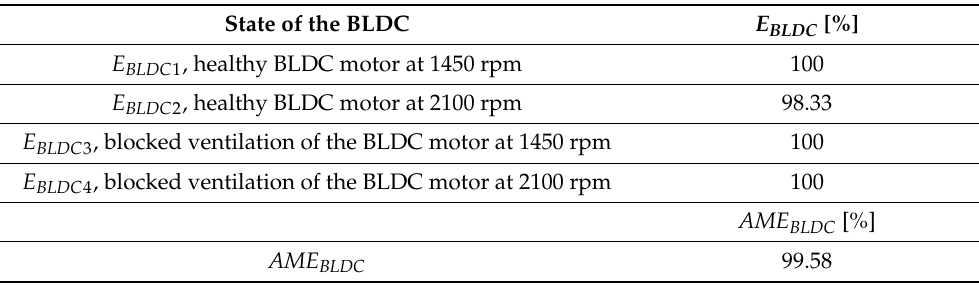
Table 2. Results of recognition for CPoAMoTI method (parameter p = 1.0) for the BLDC motor (fan).